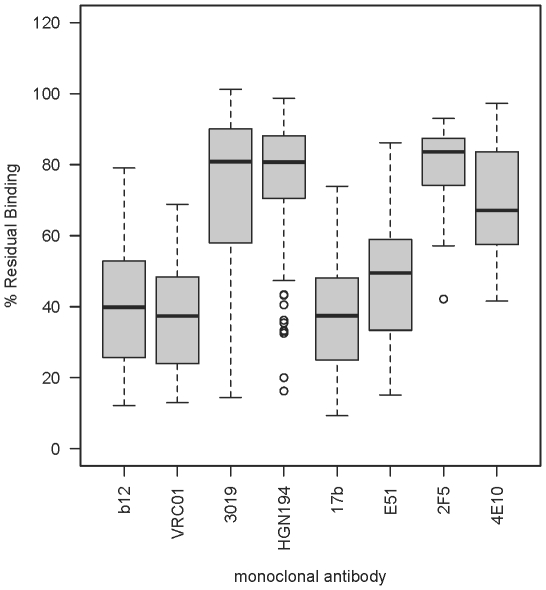
Epitope specificity across all antisera by mAb competition.Across all samples, the polyclonal antibody responses appeared be mostly CD4bs and CD4i driven, as the antisera could efficiently out-competed mAbs against these two regions (b12 and VRC01 for CD4bs and 17b and E51 for CD4i). Modest to little activities against the V3 loop or the MPER were detected.